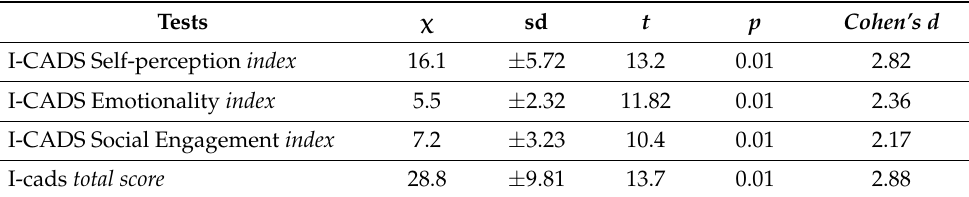
Table 5. I-CADS raw score of sample after chemotherapy treatment and t -test one sample.